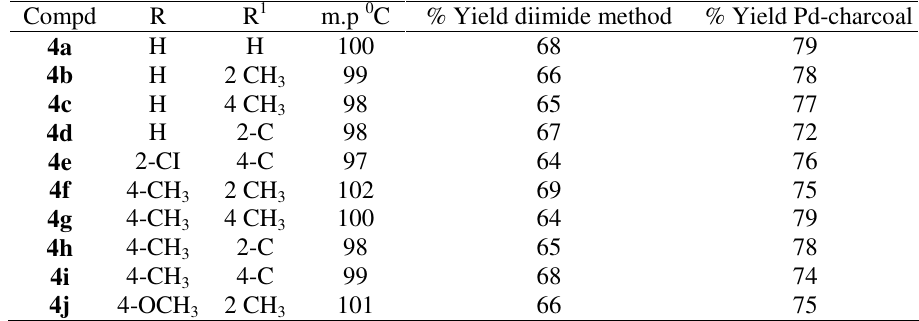
Table 1. Physical data of 3-(1, 3-diphenyl-1 H -pyrazol-4-yl) propanoic acids ( 4a-j